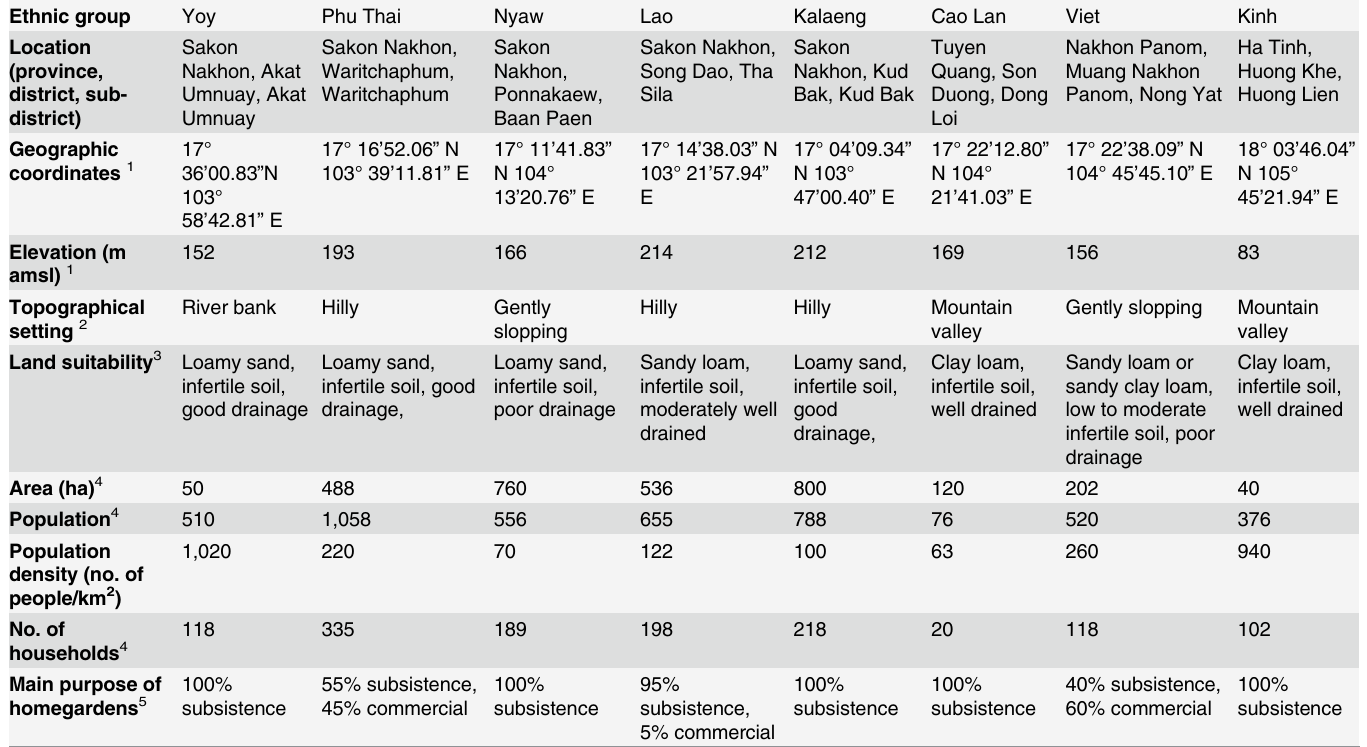
Table 1. Characteristics of study villages of different ethnic